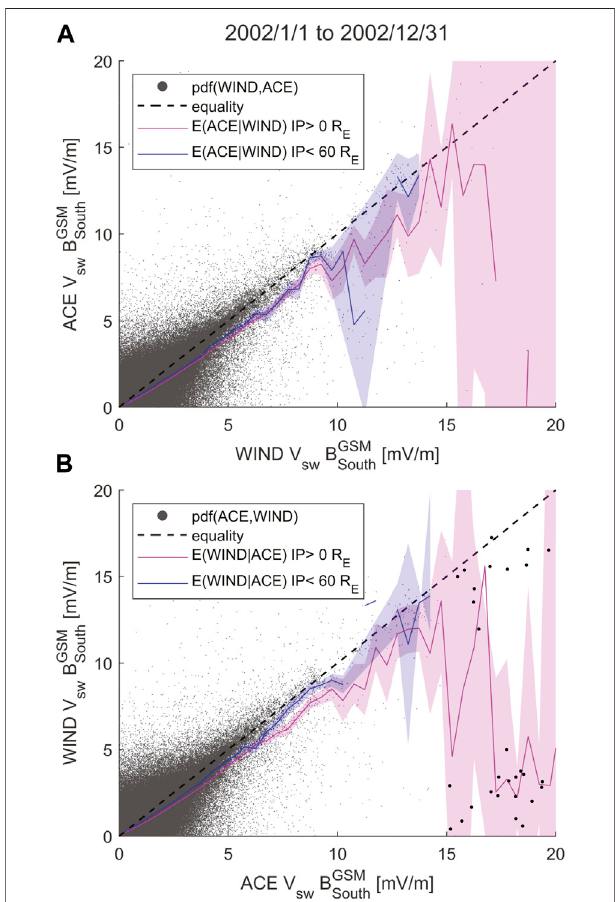
FIGURE 12 | Regression bias in solar wind driver function E sw = V sw B south , where B south (cid:2) − B GSM Z . (A) The magenta line plots the regression function E ( E ACE sw | E WIND sw ) using measurements in 2002. The blue line is the same but limited to measurements where the IP < 60 R E between ACE and WIND. (B) Plots the reverse regression function E ( E WIND sw | E ACE sw ) in magenta, and the same curve with IP < 60 R E between the spacecrafts. Note that the regression bias at extreme values here is a result of the fact that the IP between WIND and ACE were as large ~ 265 R E . The data points with ACE V sw B south between 15 and 20 mV/m are highlighted with larger